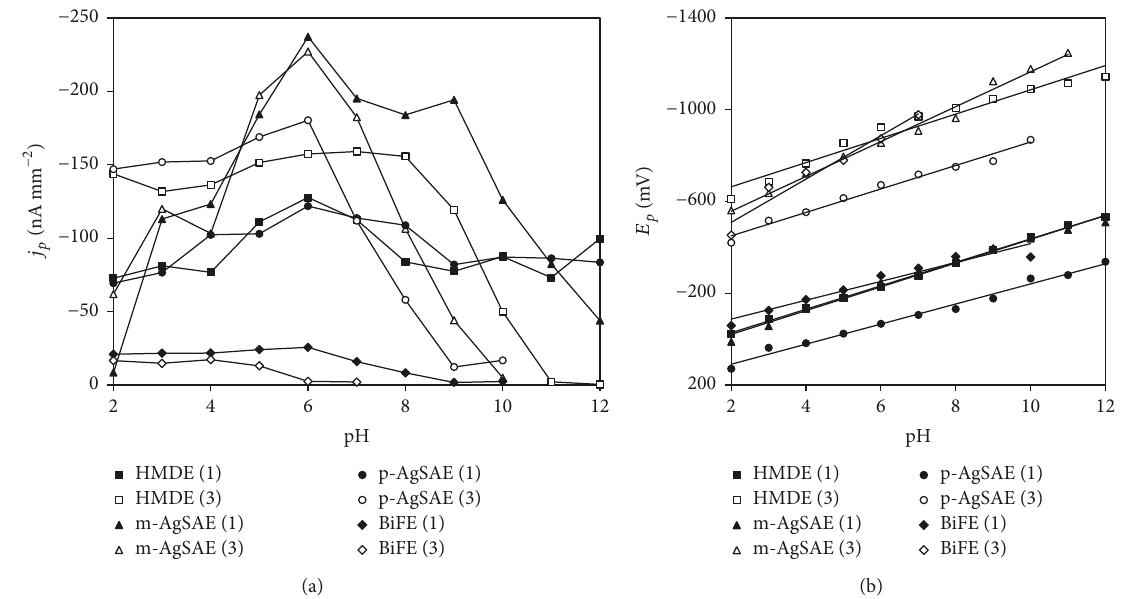
Figure 2: Dependence of 𝑗 𝑝 (a) and 𝐸 𝑝 (b) of DAN signals on pH of electrolyte obtained on all tested electrodes. Method: CV; electrolyte: BRB (pH 2.0–12); 𝐸 in = +200 mV; 𝐸 fin = − 1300 mV; V = 100 mVs −1 ; 𝑐